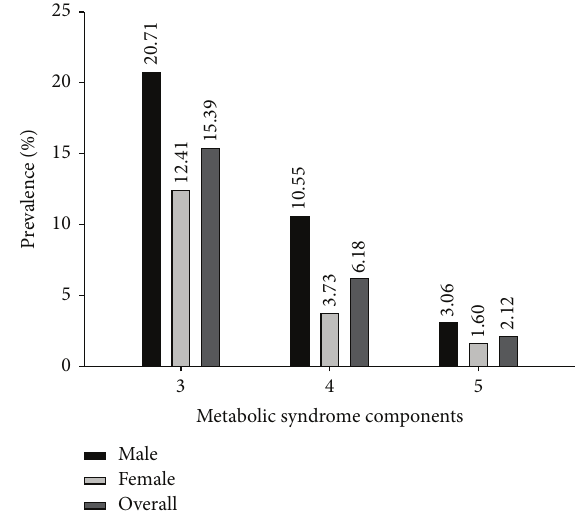
10-fold CV: 10-fold cross-validation, Acc: accuracy, Sens: sensitivity, Spec: specificity, and MCC: Matthews correlation